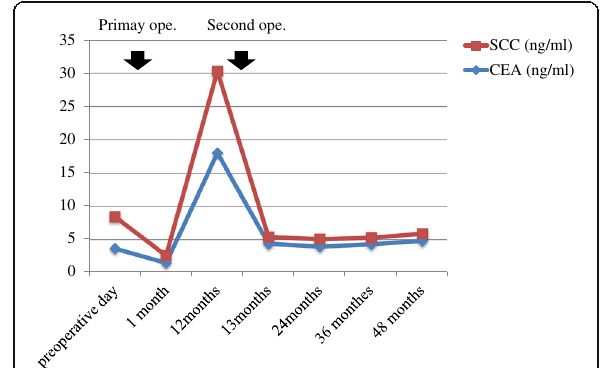
Fig. 3 Clinical changes in concentrations of tumor markers, carcinoembryonic antigen ( blue line ) and squamous cell carcinoma ( red line ). Ope operation